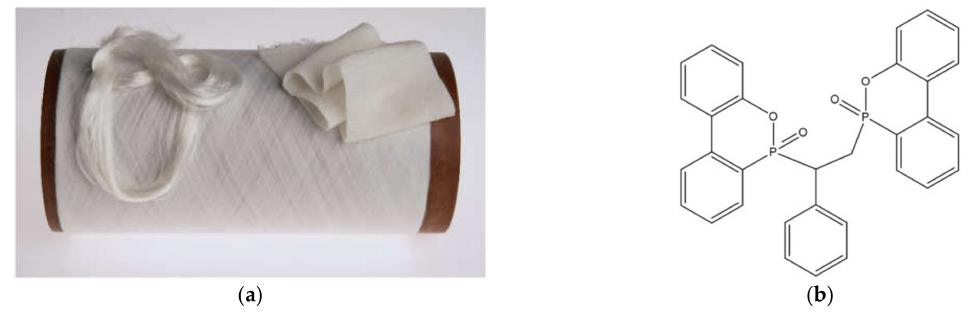
Figure 1. The flame-retardant (PA6)/bridged 9,10-dihydro-9-oxa-10-phosphaphenanthrene-10-oxide (DOPO) derivative nanocomposite filament yarns ( a ) and molecular structure of the flame-retardant bridged DOPO derivative (6 (cid:48) -(1-phenylethane-1,2-diyl)bis(dibenzo[c,e][1,2]-oxaphosphinine-6- oxide), PHED) ( b